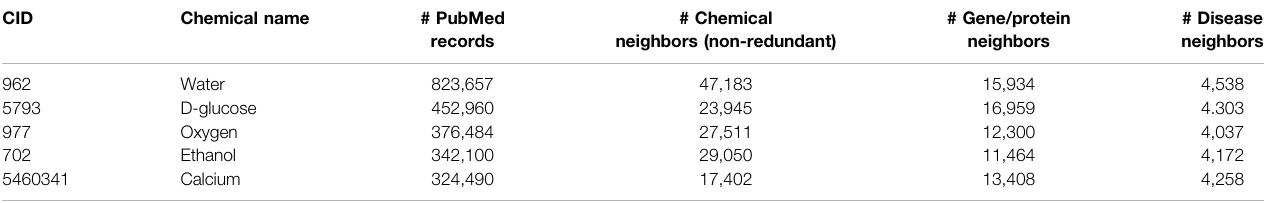
TABLE 3 | Top fi ve most mentioned chemicals in PubMed records and the number of their chemical, gene/protein, and disease neighbors. CID